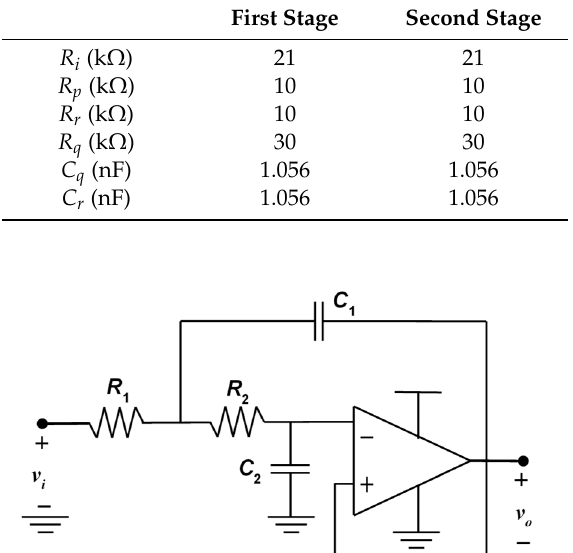
Table 2. Components of the reference-frequency band-pass filter in Figure 5.